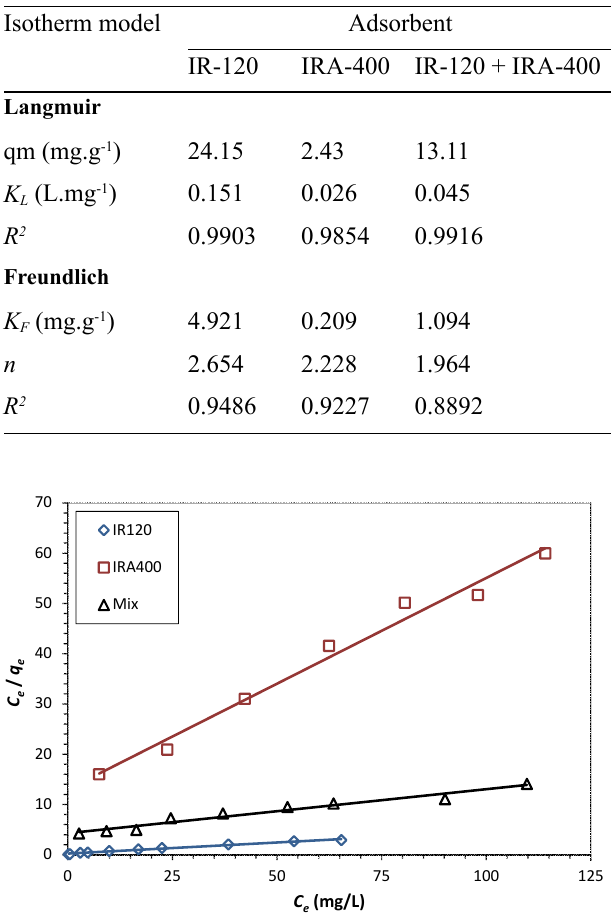
Fig 5. The Langmuir adsorption isotherm models of Th(IV) adsorption onto resins of IR-120, IRA-400 and the mix of them at T= 25 °C , pH= 4 , adsorbent dose = 1.5 g.L -1 .